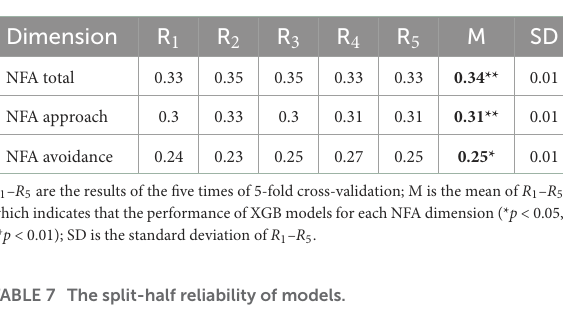
TABLE 6 The five cross-validation results of XGB.